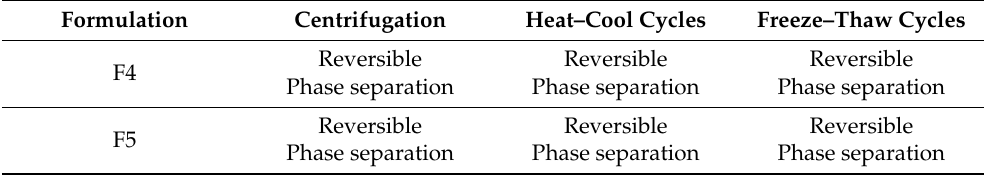
Table 4. Thermodynamic stability of the drug-loaded formulations.